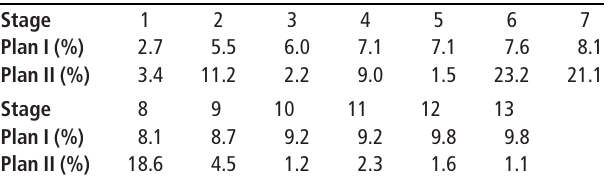
Table 5 Contribution percentages of each stage to the total objective